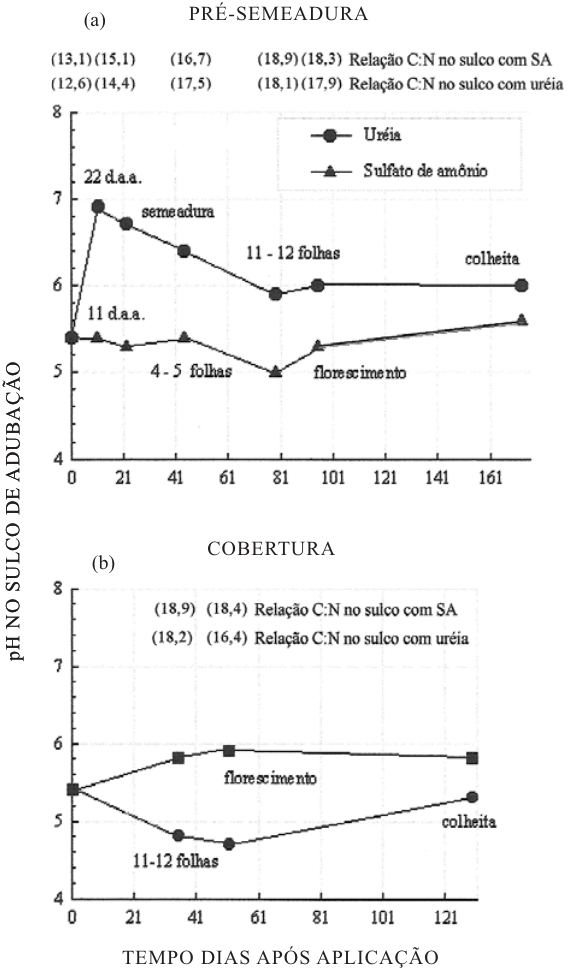
Figura 7. Variação do pH e relação C:N no sulco de adubação com aplicação de uréia e sulfato de amônio em pré-semeadura (a) e em cobertura (b) na cultura de milho (safra 2000/2001), em sistema plantio